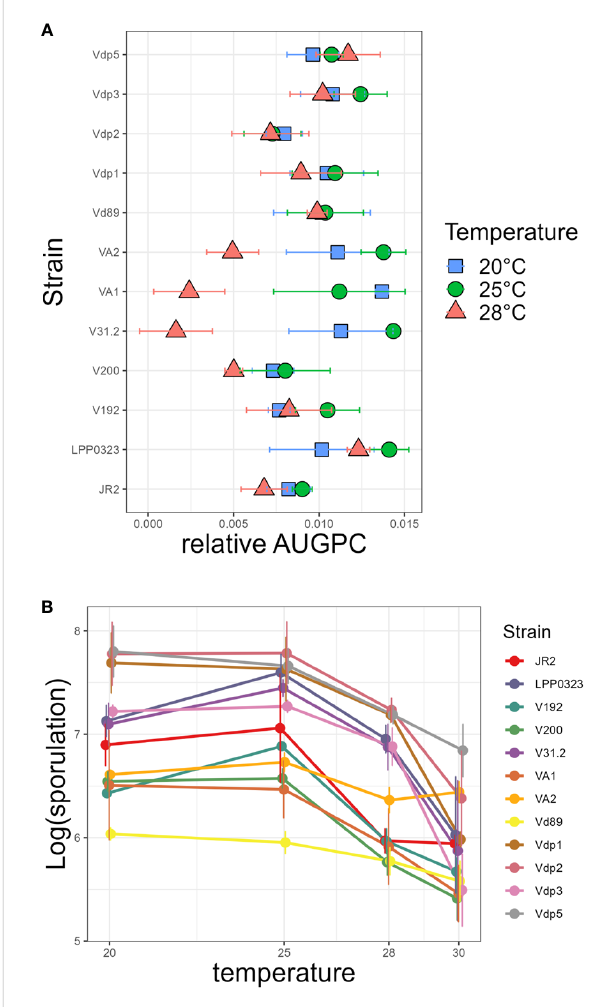
FIGURE 1 Effect of temperature on in vitro growth and sporulation of Verticillium strains. (A) strains were grown on PDA medium in Petri dishes at 20°C, 25°C and 28°C. Radial growth was measured during 14 days and expressed as Area Under Growth Progress Curve (AUGPC). (B) Conidia released into distilled water were counted with a hematocytometer. Each point shows the mean values of three independent experiments, with two Petri dishes each. Bars indicate standard error of observed